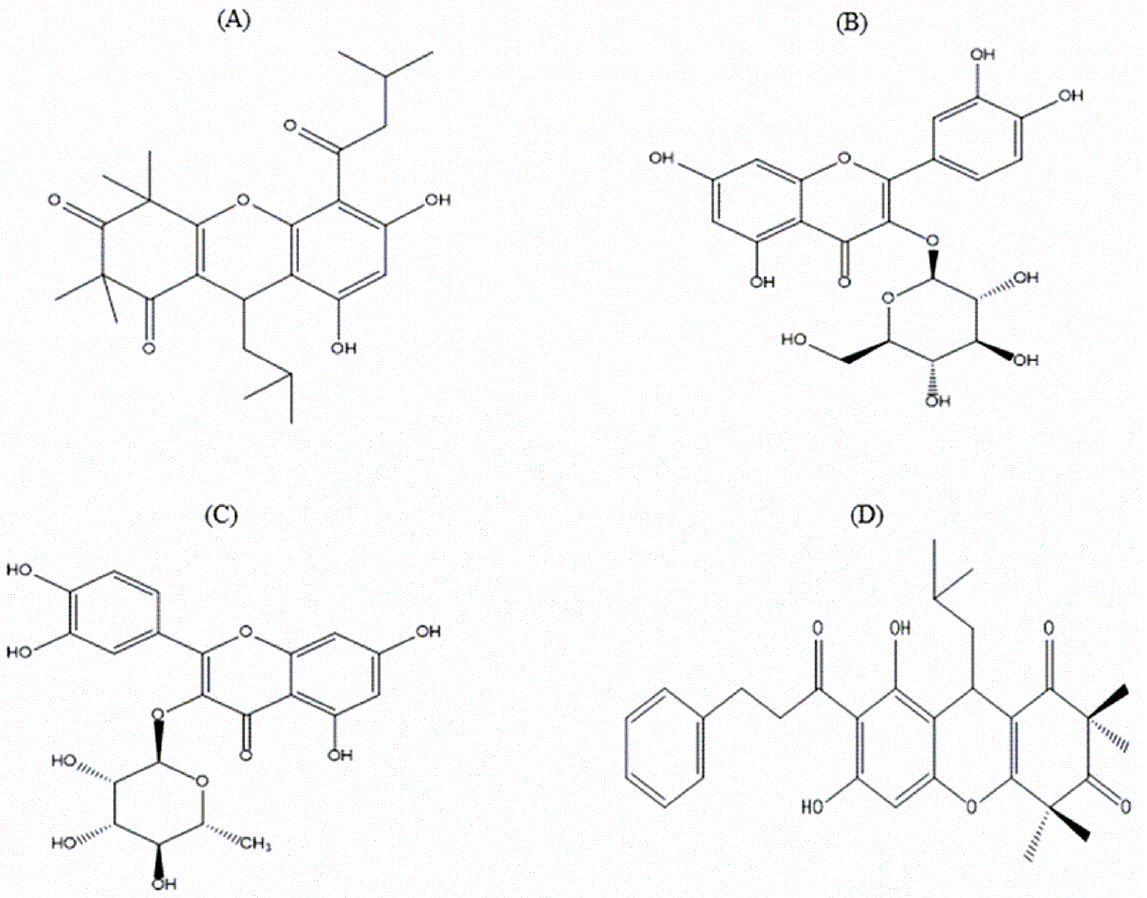
Figure 6. Chemical structure of possible phytoconstituents extracted from the EEEC. Chemical structures of ( A ) Rhodomyrtosone B, ( B ) Quercetin-3-O- β -D-glucopyranoside, ( C ) Quercitroside and ( D ) Rhodomyrtosone E with their corresponding molecular formulae: C 26 H 34 O 6, C 21 H 20 O 12 , C 21 H 20 O 11 , and C 30 H 34 O 6. Table 1. Molecular mass of peak samples of EEEC leaves obtained from the preparative RP-HPLC via LC-MS analysis.